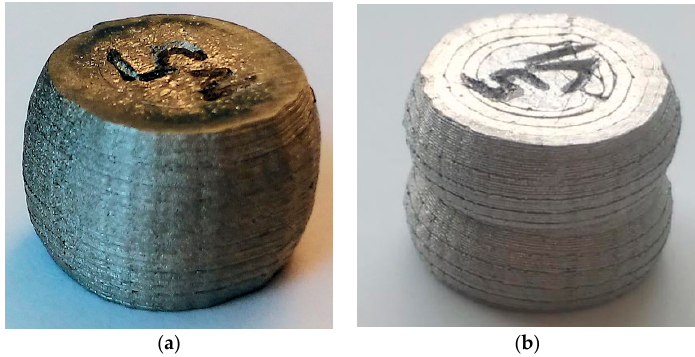
Figure 5. ( a ) Tested cylinder with 100% infill; ( b ) tested cylinder with 0% infill.